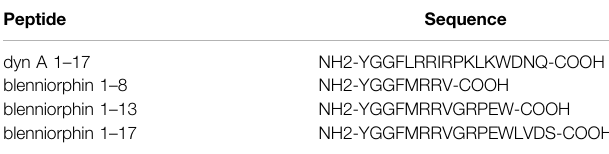
TABLE 1 | Amino acid sequences of dynorphin A and